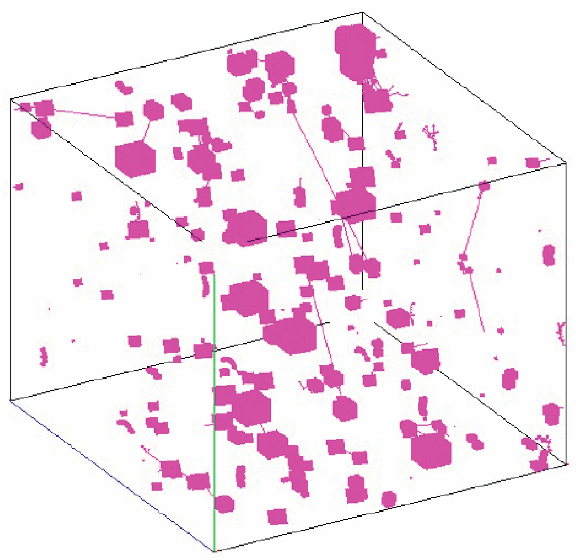
Figure 8. Three-dimensional model of the cartoon based oolitic limestone, after three phases of dissolution, showing the disconnected nature of the pores (pink). Note some pores are connected to each other (pink lines), but no connections pass through the sample, and therefore no permeability.